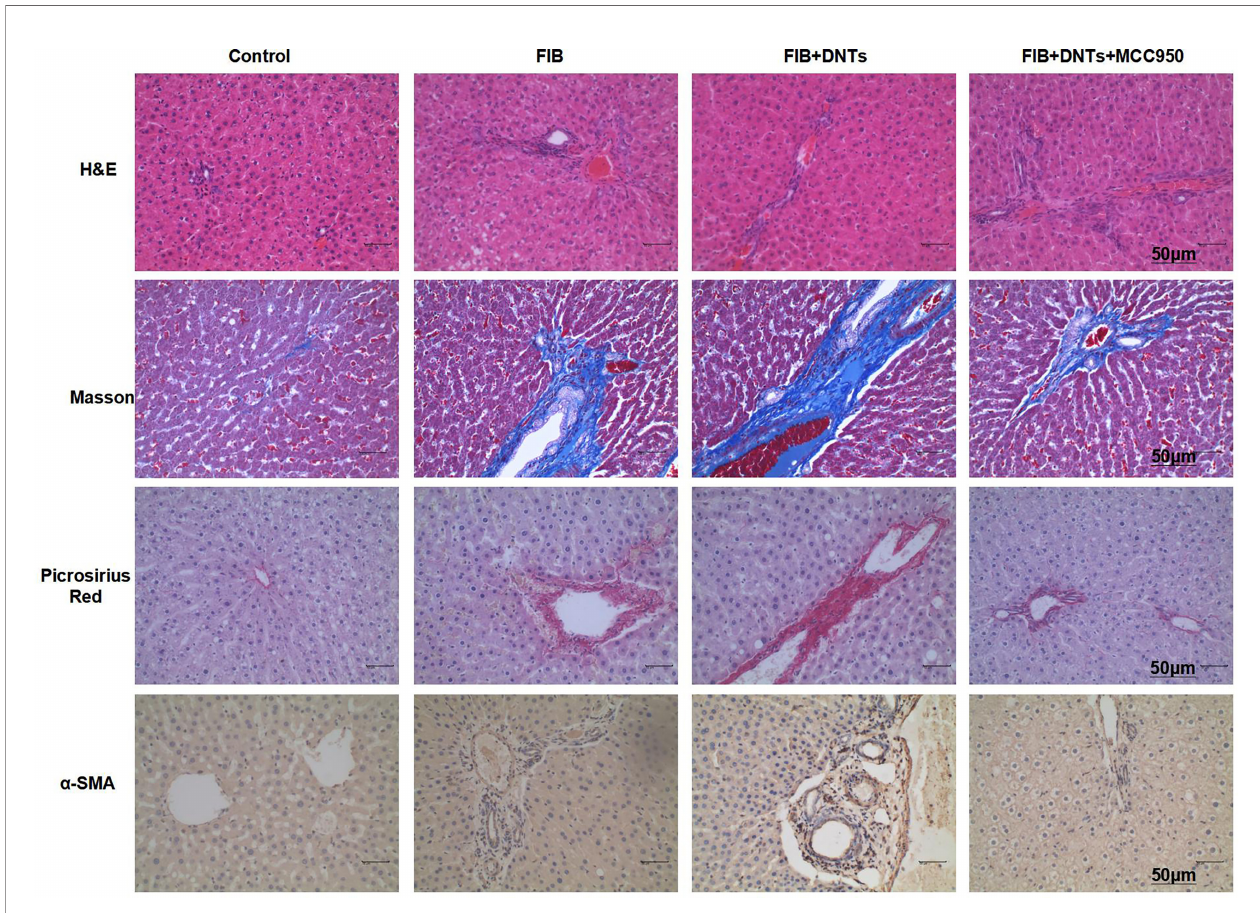
FIGURE 6 | Effect of DNTs on histopathology and fi brosis of liver fi brosis mice. H&E staining indicated obvious fi brosis lesion in FIB mice and apparent tissue in fl ammation, which were further aggravated in DNTs, along with severe liver injury, while MCC950 improved liver fi brosis degree. Masson and sirius-red staining results indicated that DNTs promoted liver fi brosis in mice, the expression of collagen fi bers and collagens further increased in hepatic tissues, higher than that in FIB, and MCC950 suppressed such changes. Moreover, IHC also revealed that DNTs promoted a -SMA expression. DNTs, double-negative T cells; HSC, hepatic stellate cell; IHC,